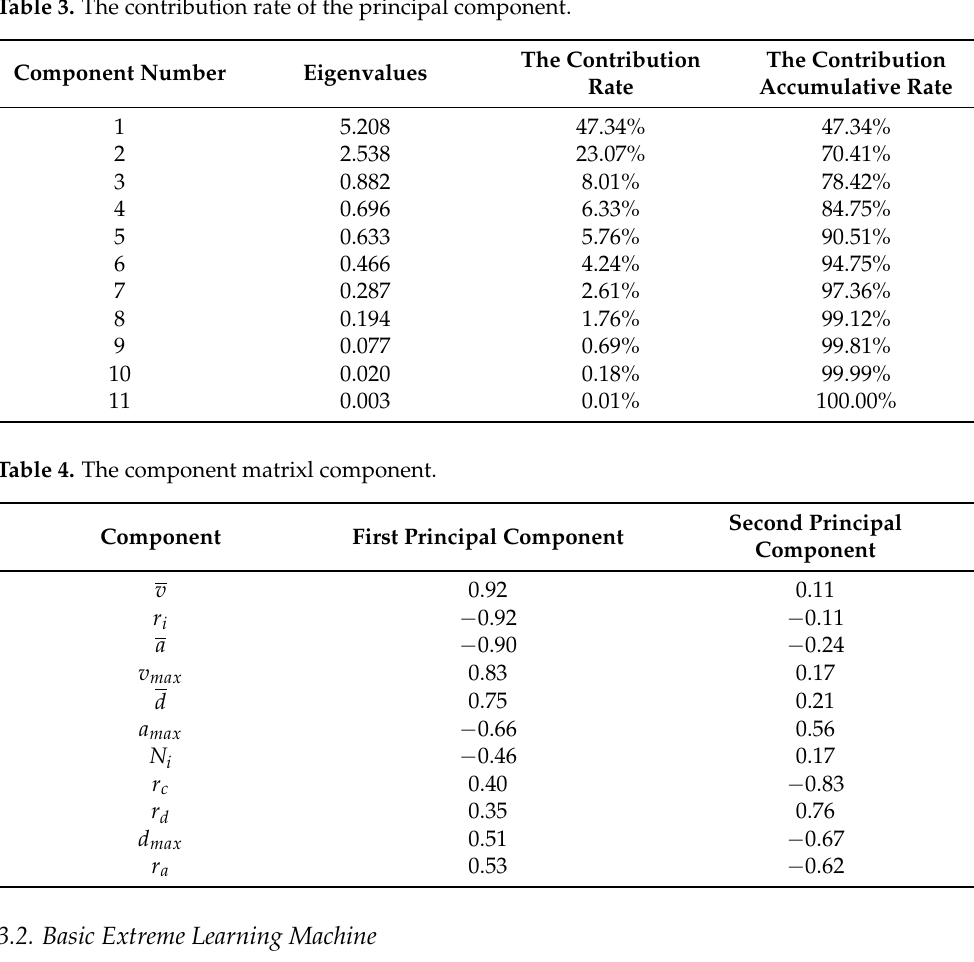
Table 3. The contribution rate of the principal component.